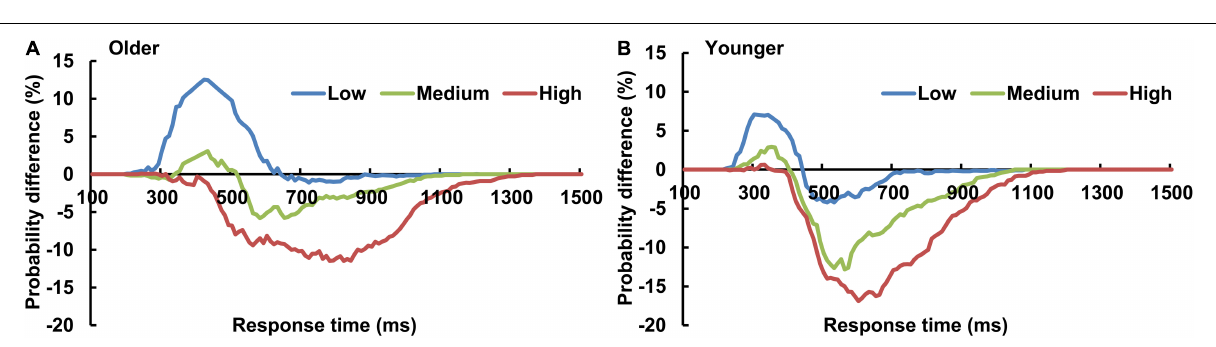
FIGURE 5 | The AVI effect changed from facilitation to depression for both older (A) and younger (B) adults with increasing of visual perceptual load. Low, low visual perceptual-load condition; Medium, medium visual perceptual-load condition; High, high visual perceptual-load